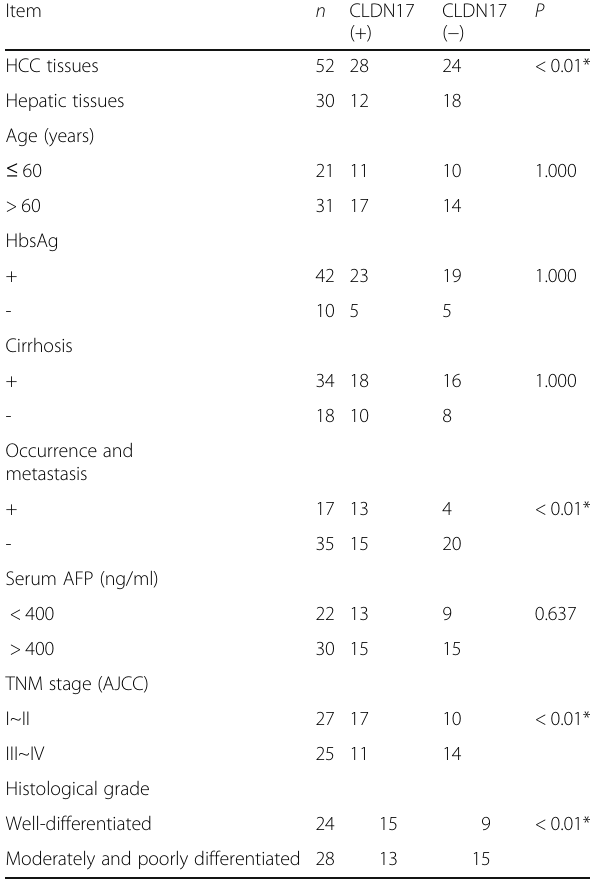
Table 1 Expression of CLDN17 and the clinicopathological characteristics in HCC